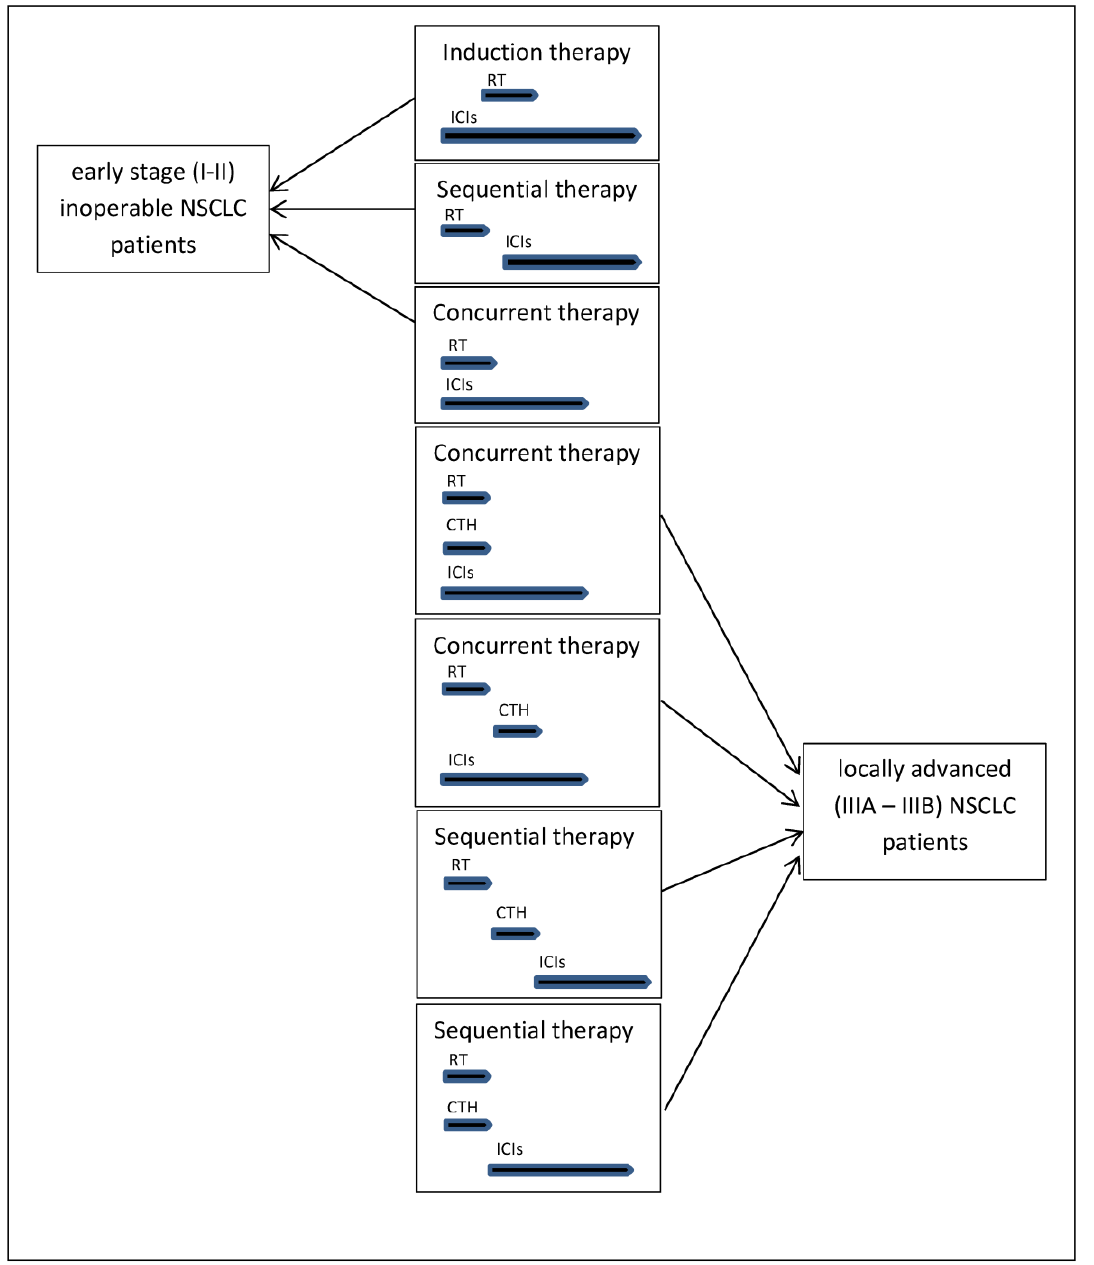
Figure 2. Different combination treatment regimens containing radiotherapy or radiochemotherapy and immunotherapy in patients in various stages of NSCLC.